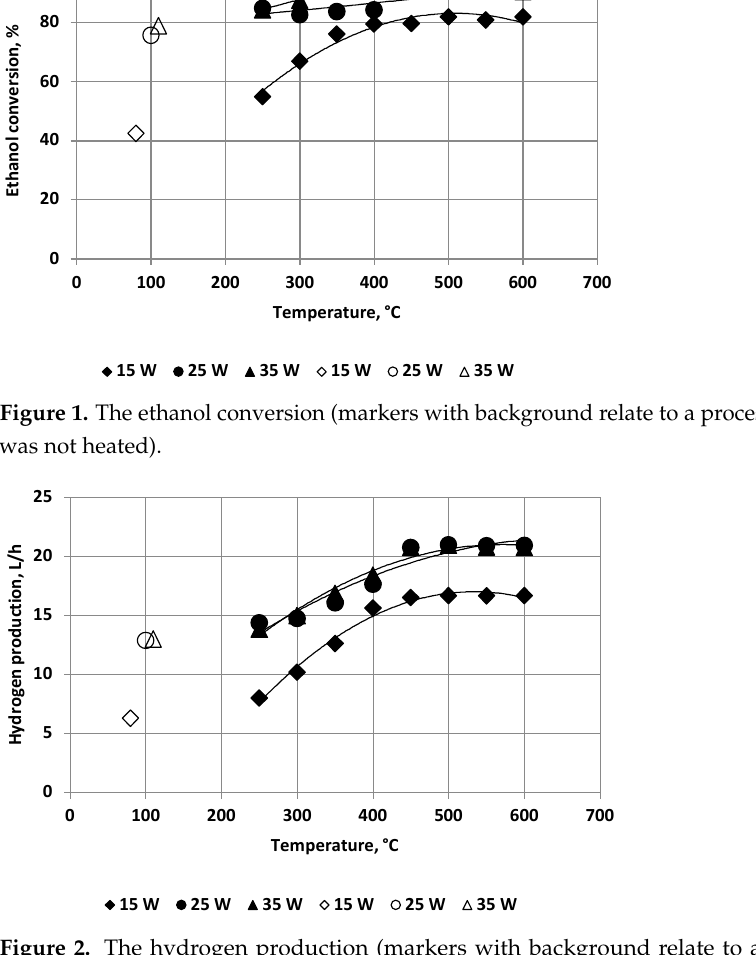
Figure 2. The hydrogen production (markers with background relate to a process in which the catalyst was not heated).